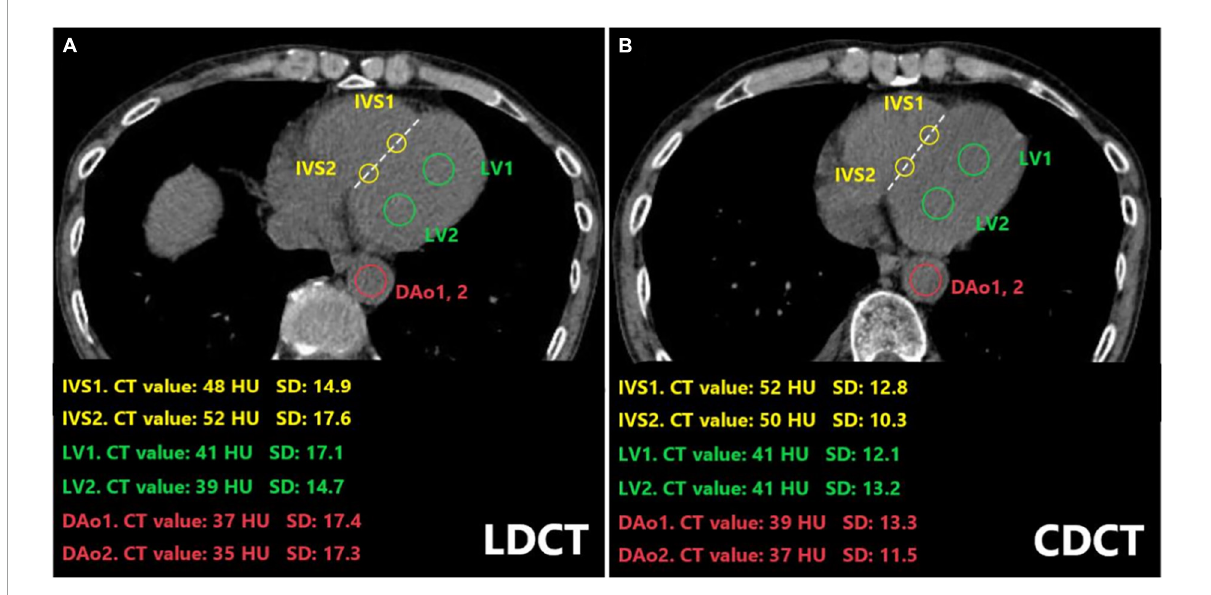
FIGURE2 Placement of ROIs in the LV, IVS, and the DAo on CT images of a 64-year-old man who underwent both LDCT (A) and CDCT examination (B). The CT value and standard deviation for each ROI were indicated. ROIs on IVS were drawn along the line between the anterior interventricular sulcus and the anteriormost aspect of the left AV groove at the level of the junction of the coronary sinus and right atrium (dotted line). LDCT, low dose computed tomography; CDCT, conventional dose computed tomography; IVS, interventricular septum; LV, left ventricular cavity; DAo, descending aorta; HU, Hounsfield Unit; SD, standard deviation; ROI, Regions of interest.